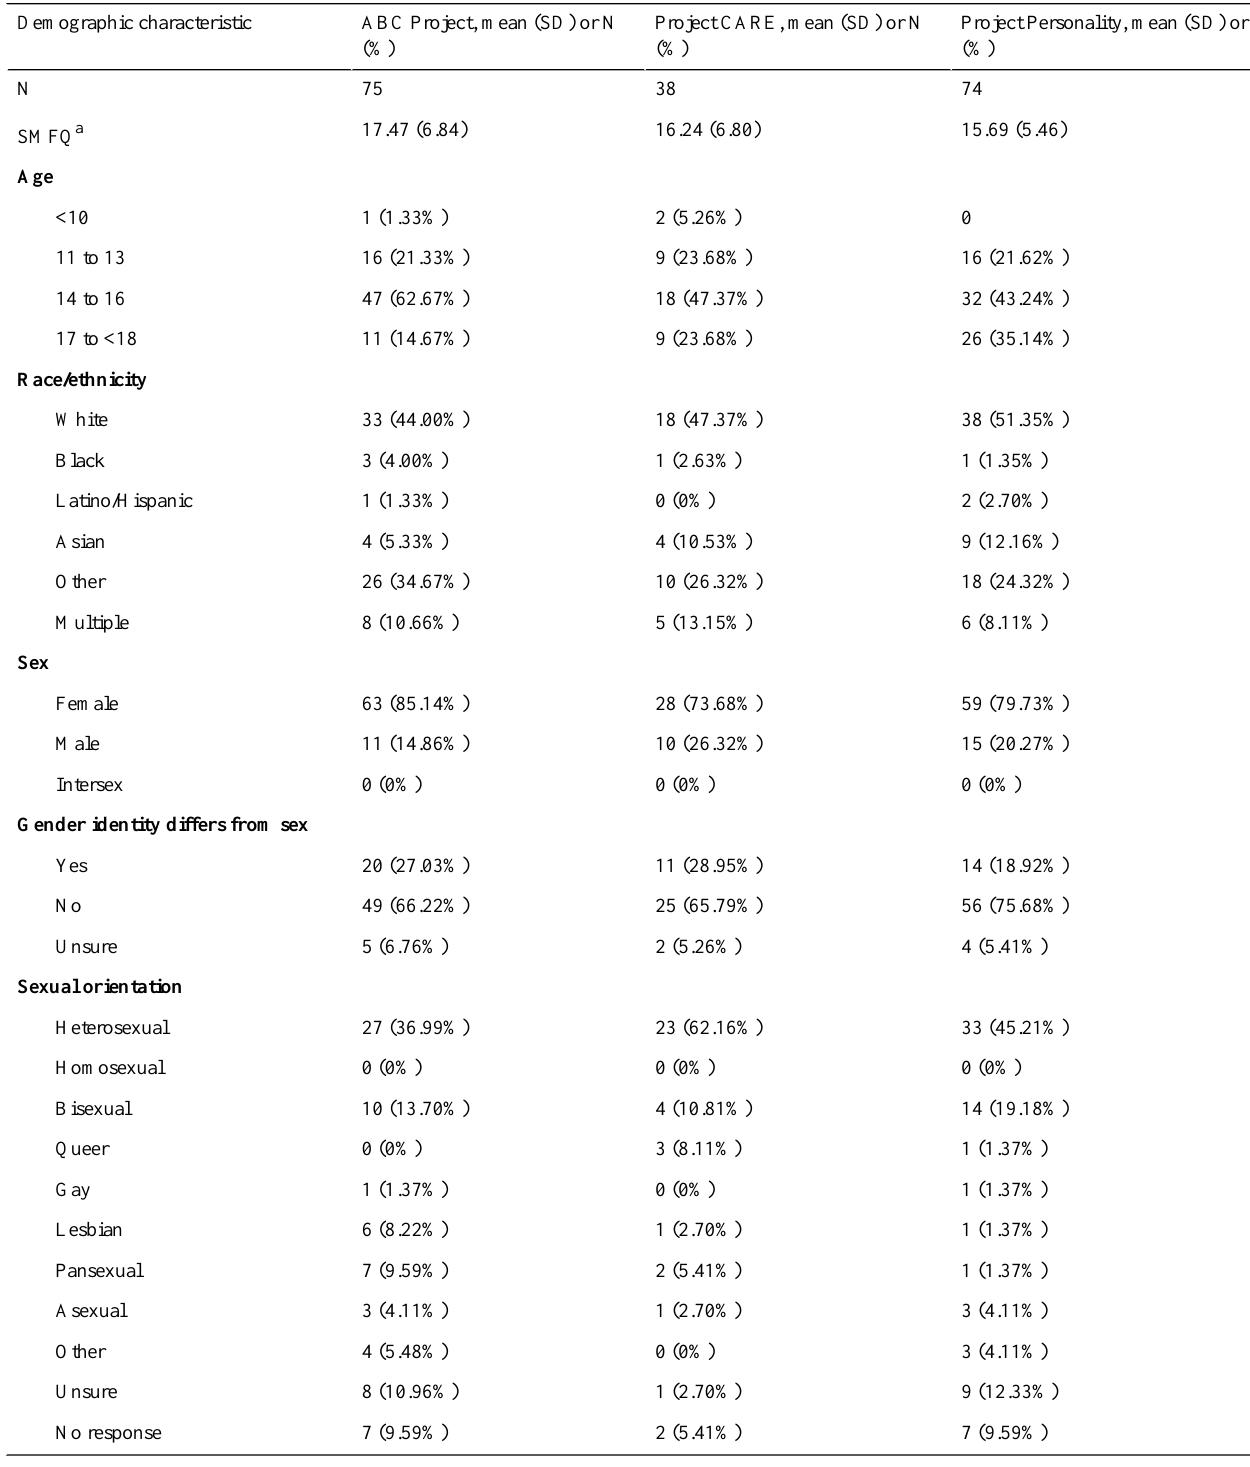
Table 2. Demographics and mean depressive symptoms among SSI completers, by selected